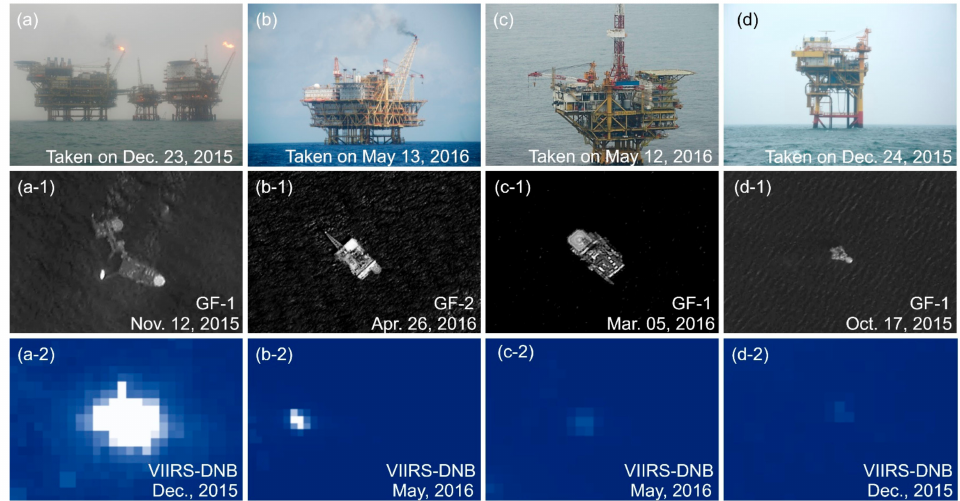
Figure 2. Image features of different HE targets: ( a ) is an oil platform group with gas flaring, ( b ) is a gas platform with gas flaring, ( c ) is a central processing platform without gas flaring, ( d ) is a wellhead platform without gas flaring; ( a-1 )–( d-1 ) are the corresponding panchromatic bands of high-resolution images; ( a-2 )–( d-2 ) are the corresponding NTL